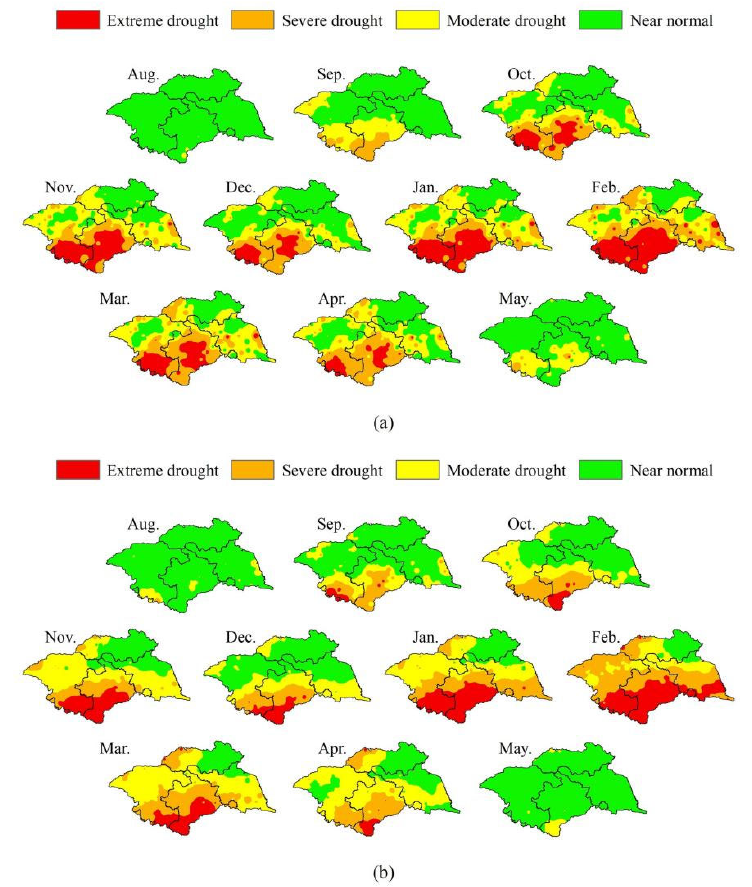
Figure 15. Spatial distribution map of SPI-12 from ( a ) gauge; and ( b ) PERSIANN-CDR for 2001–2002 drought event.